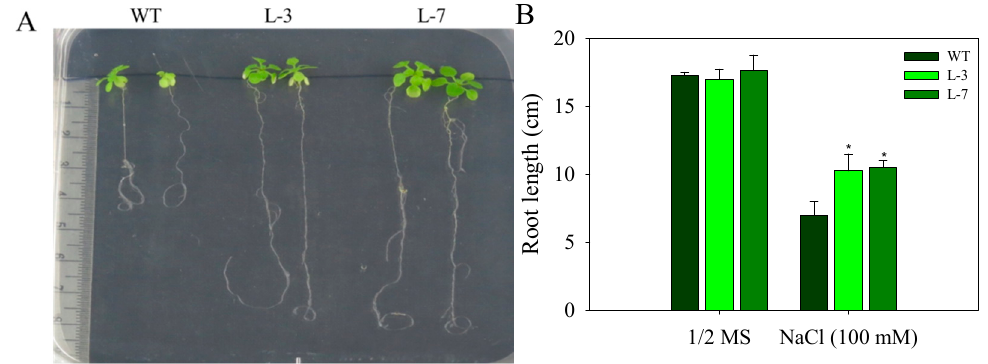
Figure 4. The growth of WT and AnnAt8 overexpressing Arabidopsis plants under normal and salt (100 mM) stress conditions ( A ) Plant growth of WT and AnnAt8 expressing Arabidopsis transgenic lines L-3 and L-7 under NaCl (100 mM) stress. Three replicates were used per treatment, and the experiment was repeated thrice. ( B ) Root length of WT and AnnAt8 expressing Arabidopsis transgenic plants under normal and salt stress. In each case, observations were made after 44 days from germination. For root length measurement, average value for 15 plantlets of WT and transgenic lines was taken for each biological replicate (n). Data represent means of n = 3 ± SE. One asterisk indicates that the mean values of transgenic lines were significantly higher than that of WT (control), when analyzed by one-way ANOVA ( p < 0.05).